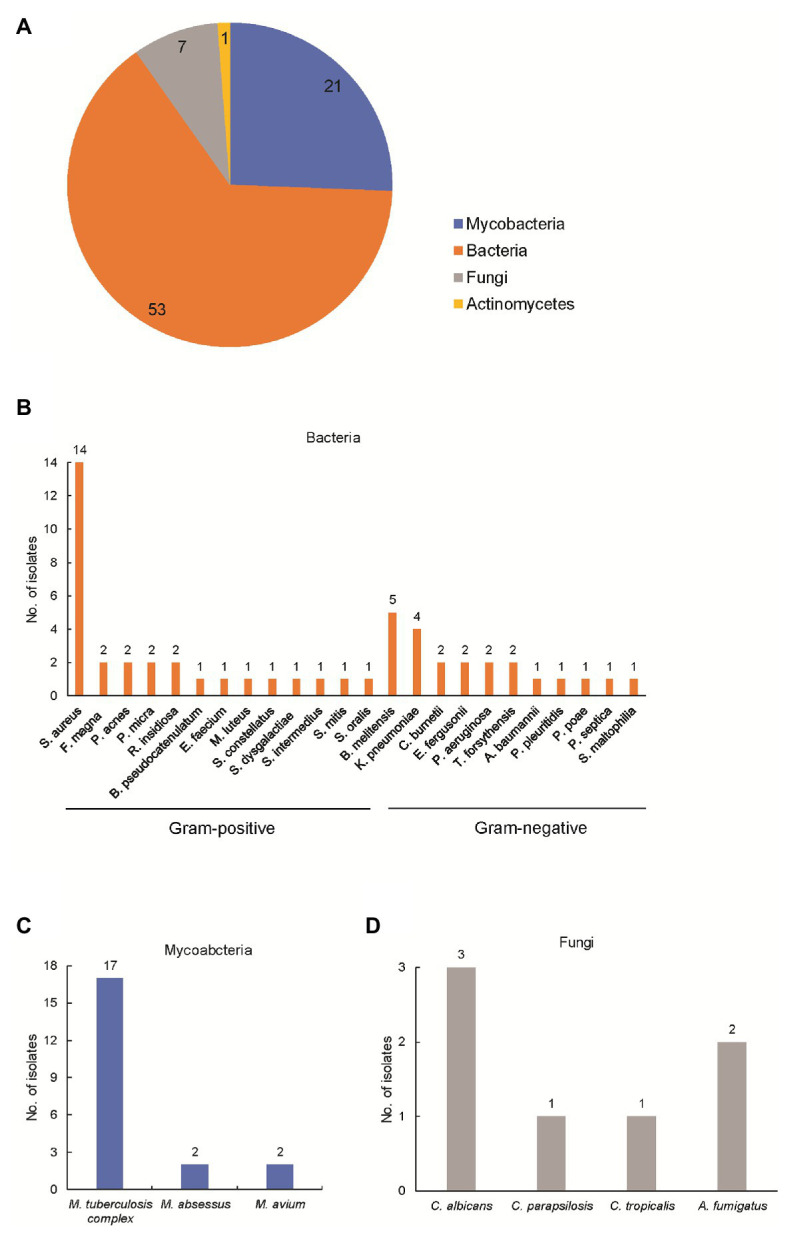
Detection of pathogens by metagenomic next-generation sequencing (mNGS) in patients enrolled in this study. (A) Composition of pathogens stratified to bacteria, mycobacteria, fungi, and actinomycetes. The number represents the cases infected with the corresponding pathogen; (B) composition of bacteria in patients enrolled in this study; (C) composition of mycobacteria in patients enrolled in this study; and (D) composition of actinomycetes in patients enrolled in this study.